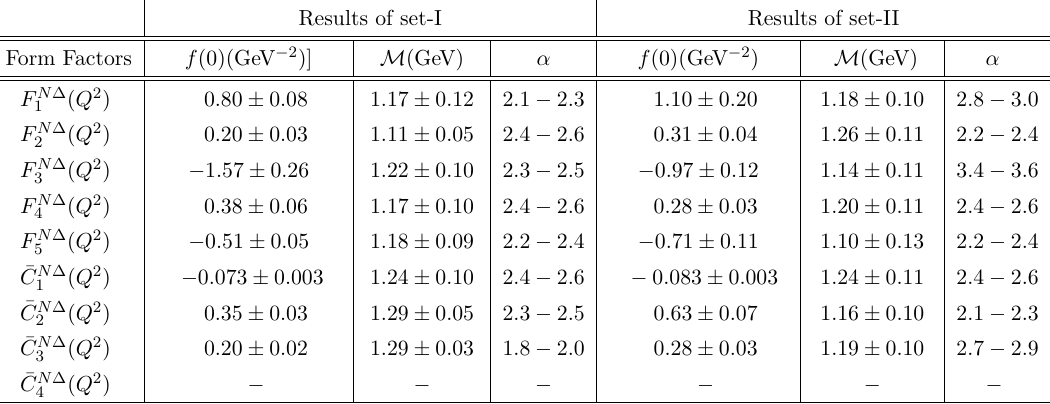
Table 2 . Numerical values of the fitting parameters for the transition GFFs of N − ∆